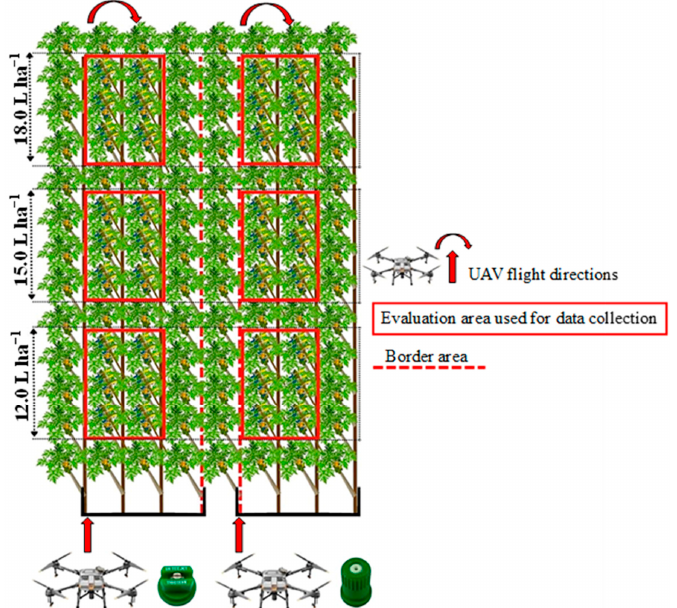
Figure 3. Experimental design of the experiment.